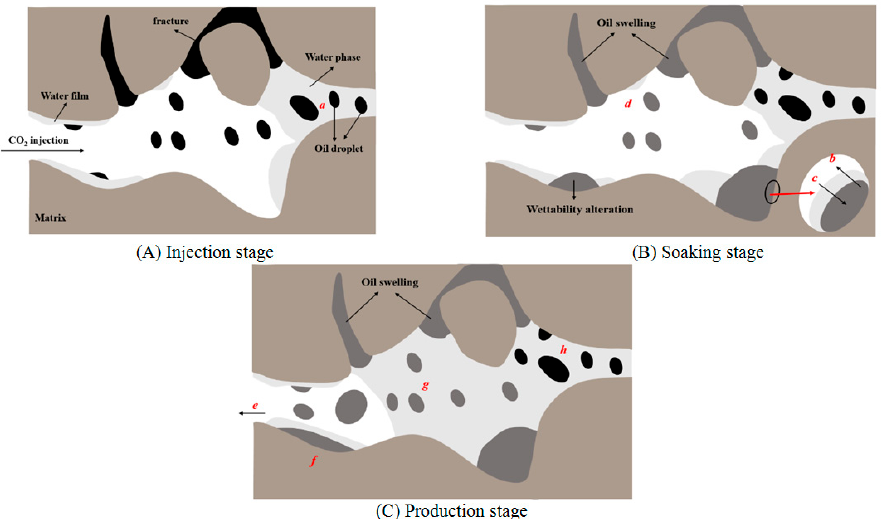
Figure 3. Process of CO 2 huff and puff for a heavy-oil reservoir: (a) oil droplets are pushed to the depth of the reservoir by CO 2 ; (b) the light component is extracted by CO 2 ; (c) CO 2 is dissolved in the heavy components; (d) oil droplet expansion; (e) flow direction of liquid; (f) residual oil due to changes in rock wettability; (g) oil droplets generated by crude oil expansion during production; (h) oil droplets are displaced from the deep formation by the water phase.